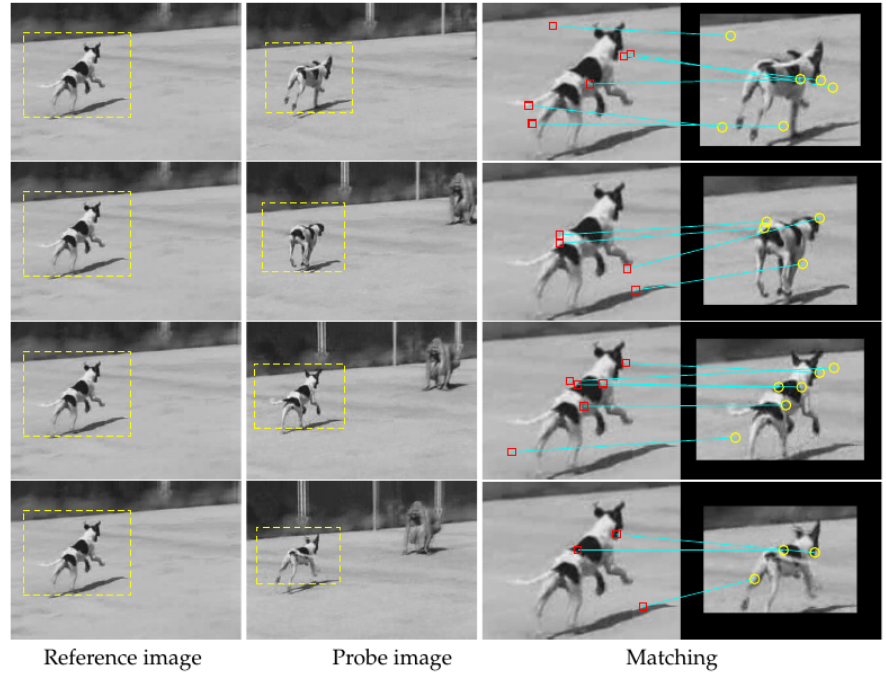
Figure 7. First target tracking test. In the first two columns, moving objects are marked, and, in the last column, there are marked key-points (as red squares and yellow circles) with an indication of their position on two different frames with a blue